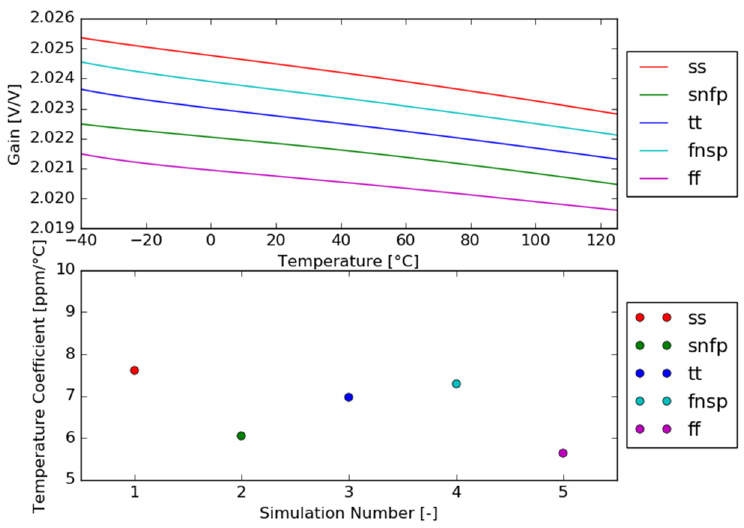
Figure 9. Process corner simulations of PGA voltage gain.